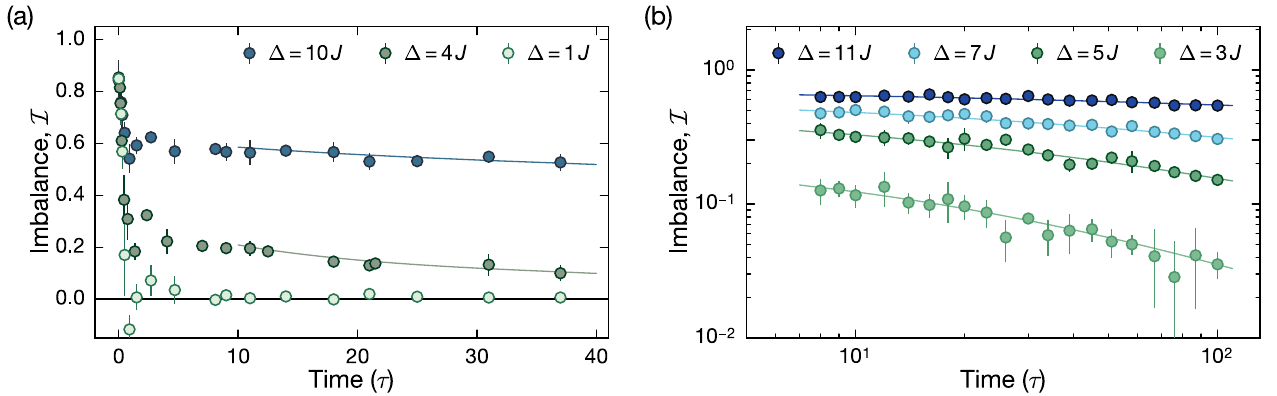
FIG. 2. Time evolution of an imprinted density-wave pattern in the interacting, two-dimensional Aubry-Andr´e model. We measure the time evolution of the imbalance between atom numbers on even and odd stripes for intermediate interactions U ¼ 5 J and varying disorder strength Δ . (a) At weak disorder ( Δ ¼ 1 J ), the imbalance vanishes quickly within a couple of tunneling times, signaling ergodic dynamics. For intermediate disorder ( Δ ¼ 4 J ), we observe a markedly slow relaxation. At even stronger disorders ( Δ ¼ 10 J ), relaxation is absent up to a weak, previously measured [40] coupling to the environment. (b) The same time evolution is shown on a double logarithmic plot for additional values of the disorder strength. The solid lines denote fits to the model described in the main text [Eq. (2)]. In both plots, error bars denote the error of the mean from six individual experimental realizations. All times are in units of the tunneling time, τ ¼ h= ð 2 π J Þ